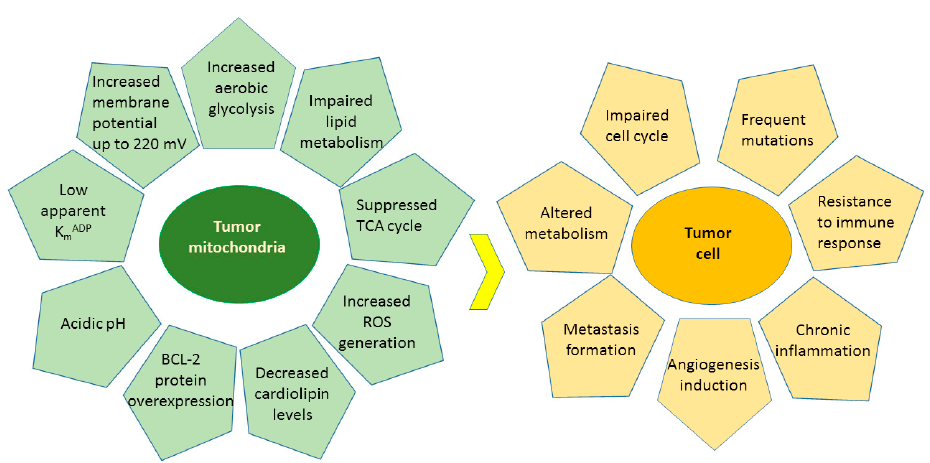
Figure 8. The main characteristics of tumor mitochondria and tumor cells.